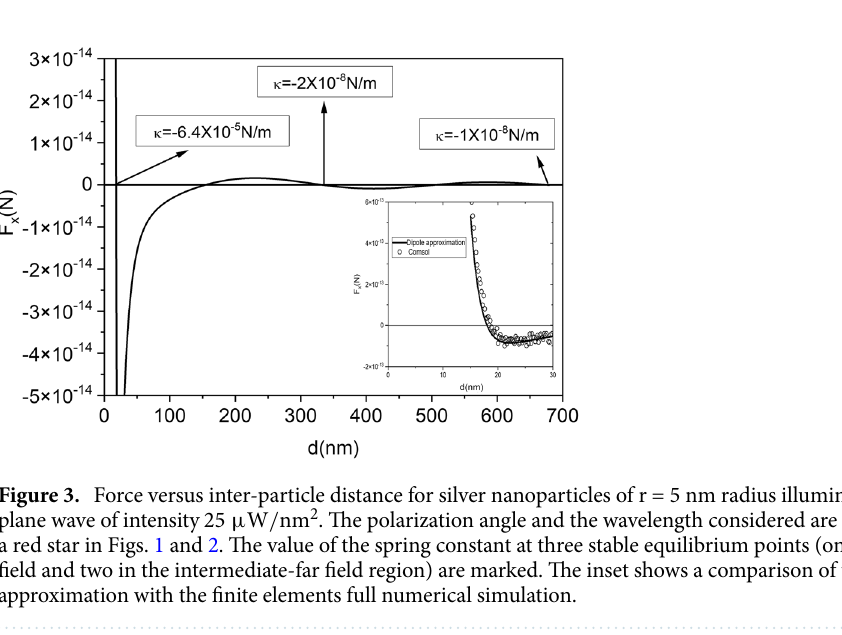
Figure 2. Logarithm color map of the spring constant (in N/m) versus equilibrium distance and wavelength. Negative spring constant (stable equilibrium points) are plotted in blue while positive spring constants (unstable equilibrium points) are plotted in red. Results are for r = 5 nm radius silver nanoparticles illuminated with a plane wave of intensity 25 µ W / nm 2 . Inset shows the real part of the particle polarizability versus wavelength. Stable binding is obtained when Re (α) < 0 .